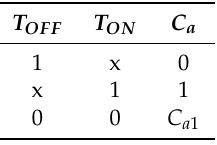
Figure 12. Limit controller schematic for ON/OFF operation of EB (a) upper temperature limit (b) lower temperature limit . Table 3. Truth table for control of EB based on outputs of Figure